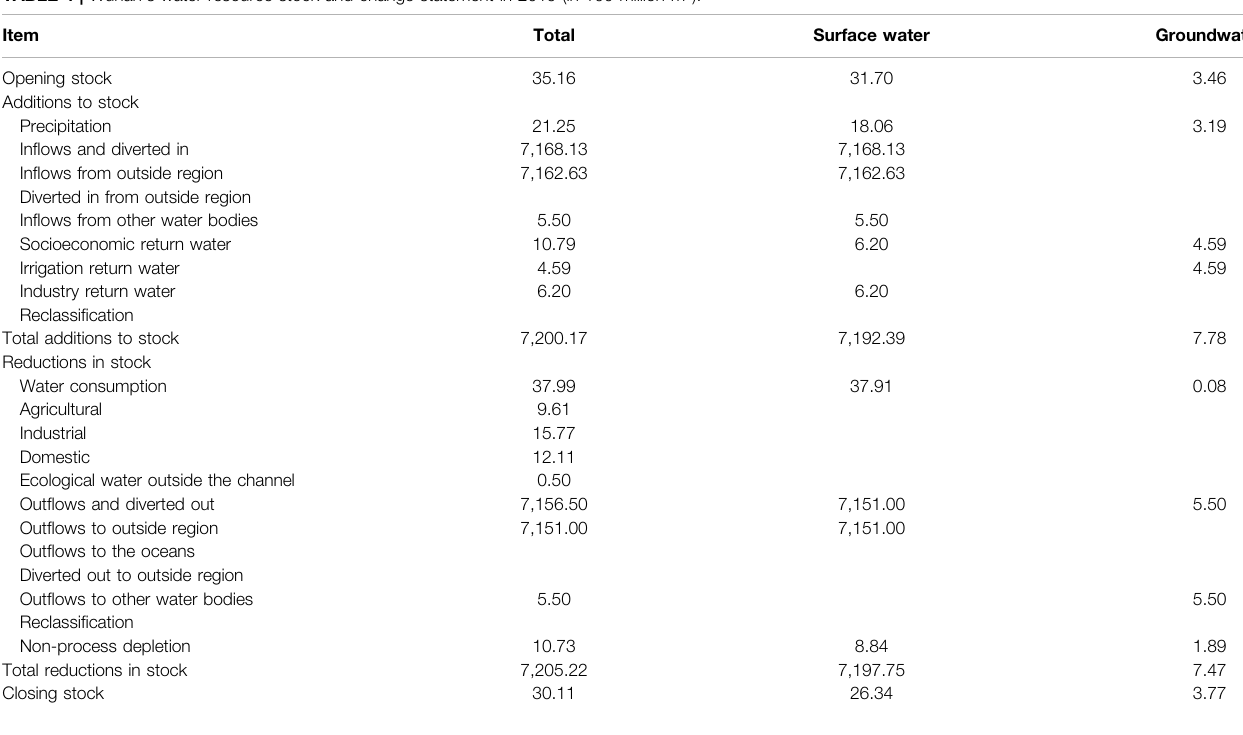
TABLE 4 | Wuhan ’ s water resource stock and change statement in 2019 (in 100 million m 3